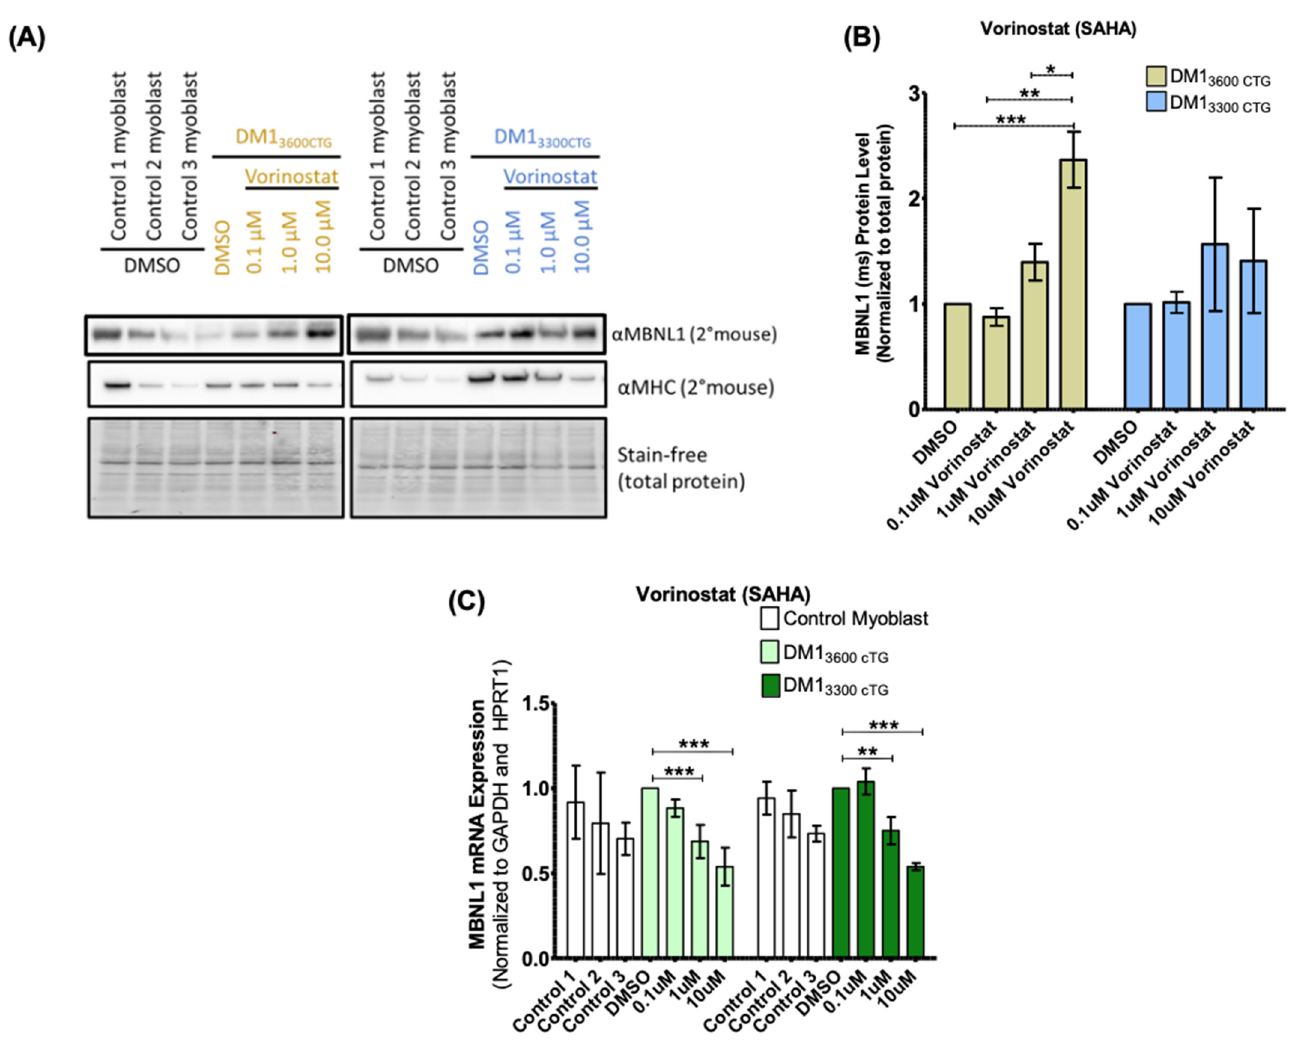
Figure 4. Vorinostat increased MBNL1 protein in DM1 3600CTG differentiated myoblasts but decreased MBNL1 mRNA. ( A , B ) DM1 3600CTG and DM1 3300CTG myoblasts were serum-starved in 6 cm plates